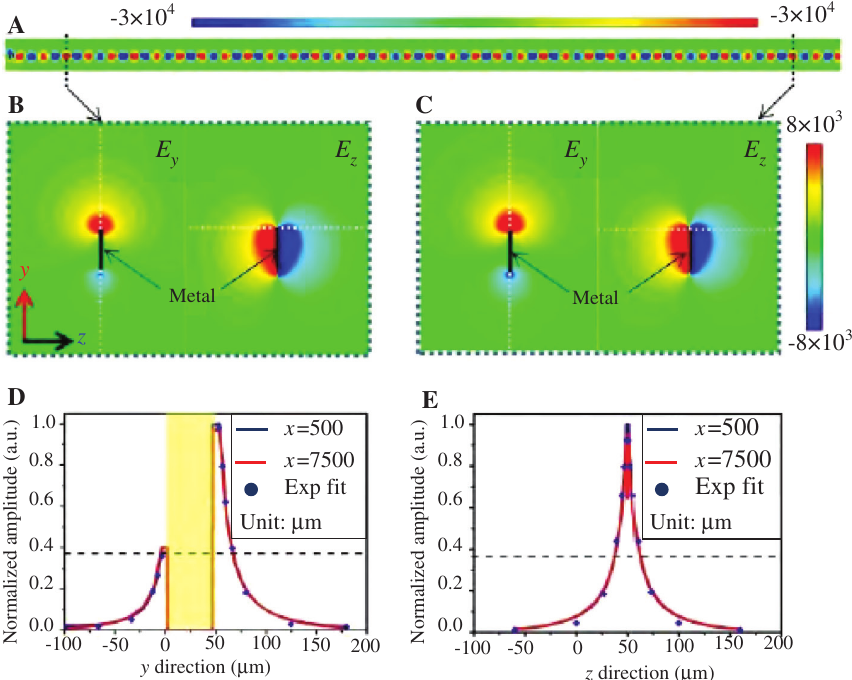
) of the SPP z and E along the white-dot lines marked y z